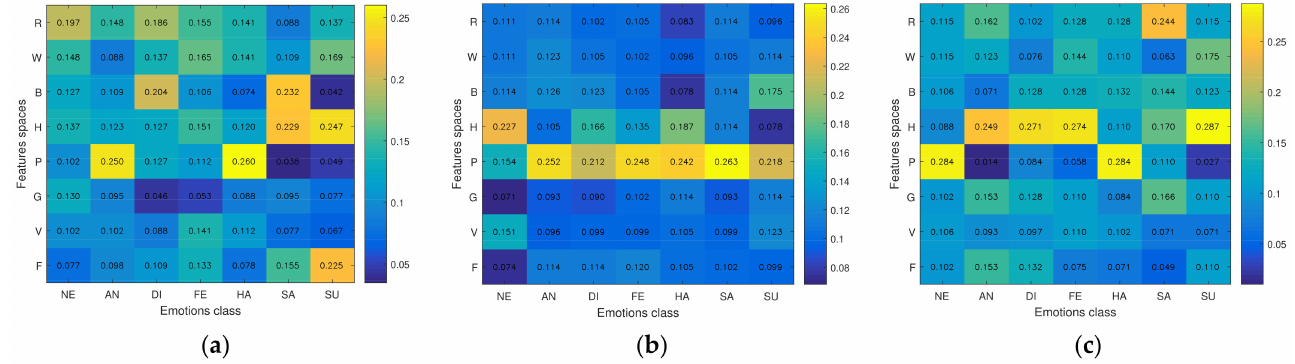
Figure 5. Weight map learning for the combination of all features. NE: neutral; AN: anger; DI: disgust; FE: fear; HA: happy; SA: sadness; SU: surprise. ( a ) CK+ data set; ( b ) BU-3DFE data set; and ( c ) JAFFE data set.